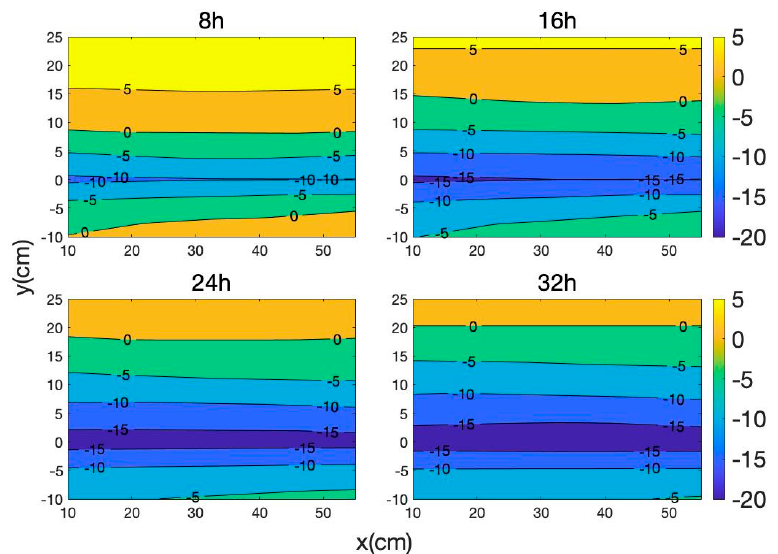
Figure 7. Temperature distribution nephogram during the freezing stage ( x stand for the horizontal position and y stand for the distance from the freezing center).